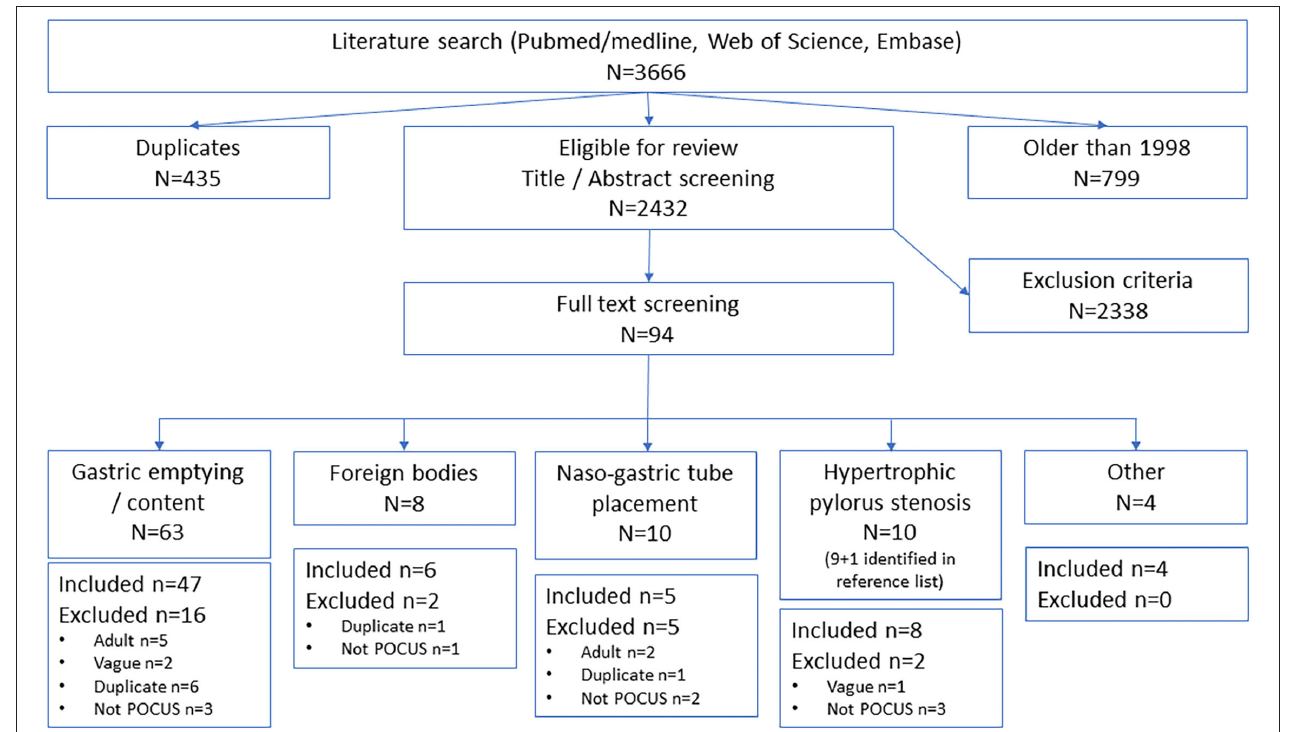
FIGURE 1 | Prisma flow